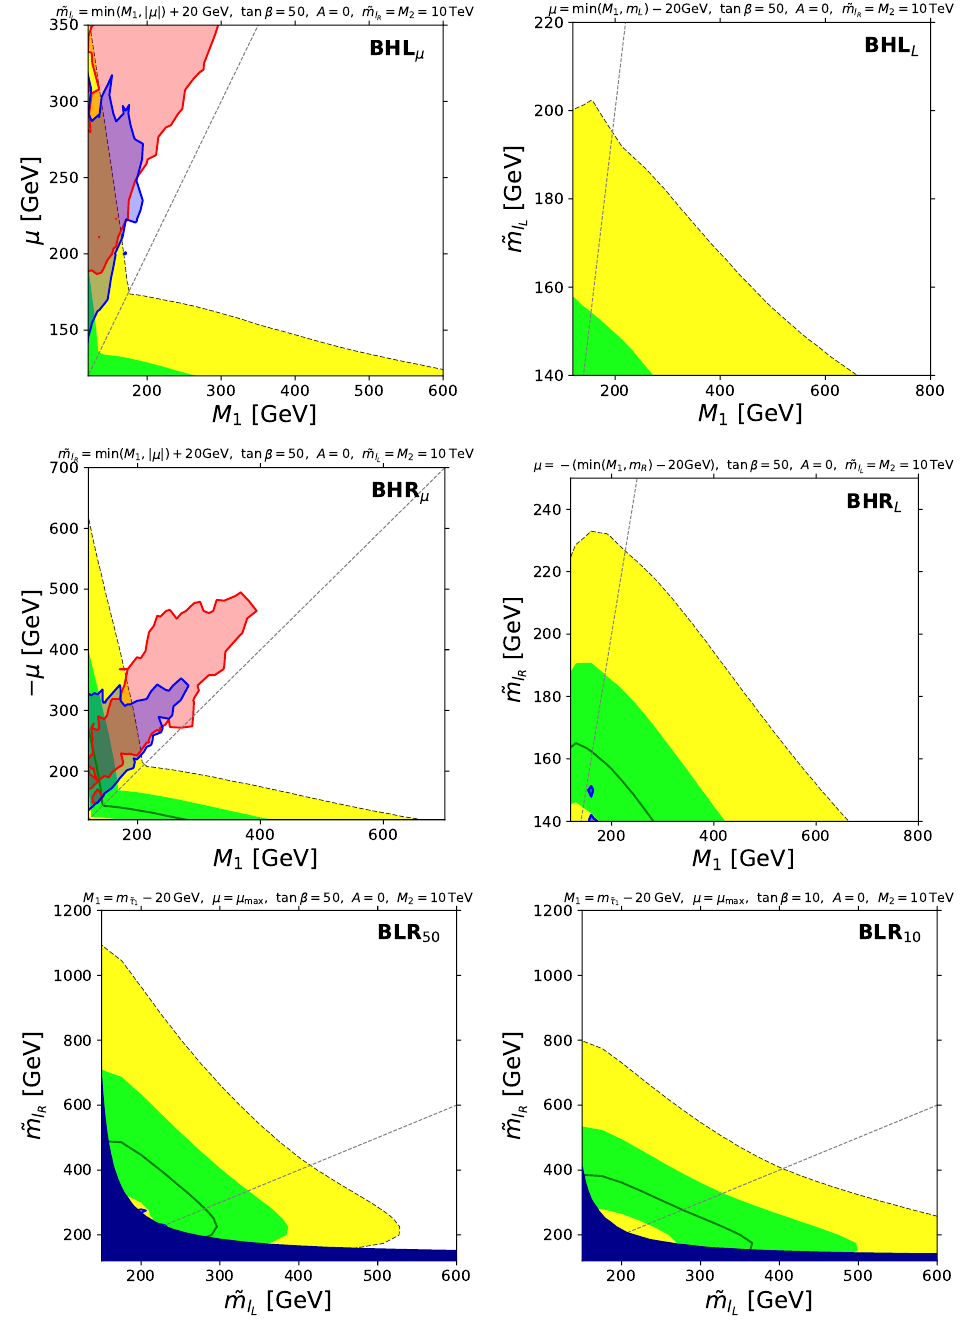
Figure 7 . Results for RPV BHL µ (upper left), BHL L (upper right), BHR µ (middle left), BHR L (middle right), BLR (lower left) and BLR (lower right) planes. Region of parameter space 50 10 allowed by the latest a experimental results [4] is depicted with green and yellow bands, corre- µ sponding to one and two sigma agreement respectively. Blue and red shaded regions are excluded by LHC constraints. Dark blue shaded area is excluded by LEP stau mass bound